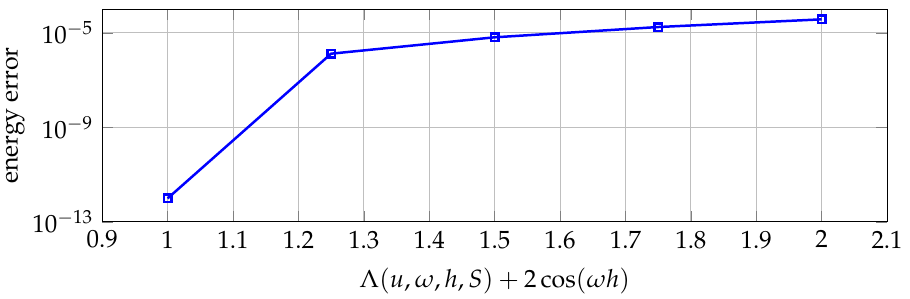
Figure 1. Energy error for the harmonic oscillator of frequency ω = 1 using the exponential varia- tional integrator for the discrete Lagrangian of (28) and for different solutions of u from Equation